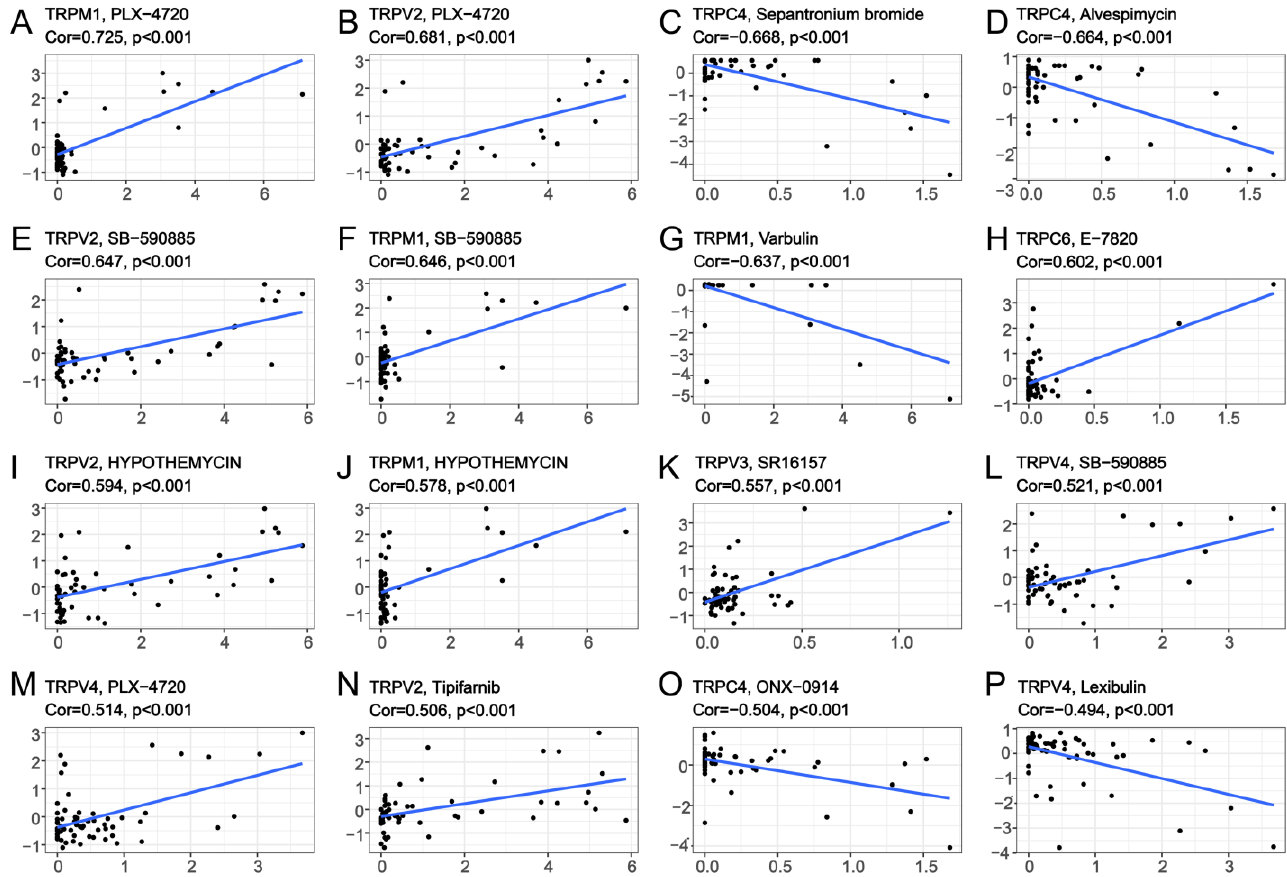
Figure 8. Drug sensitivity analysis of TRP family genes. The x-axes are the sensitivity of certain drugs and the y-axes are the expression level of certain TRP family members.